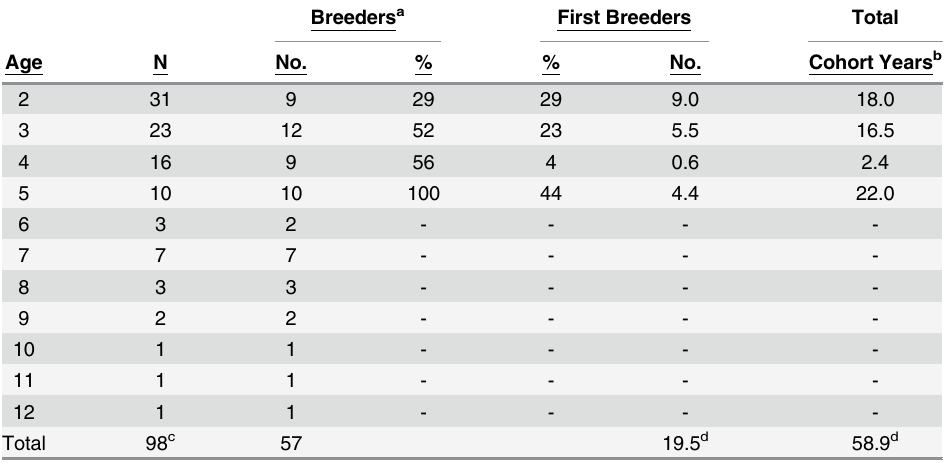
Numbers of fi rst breeders times age. c Includes 54 non-breeders plus all current and former breeders (Table 3).